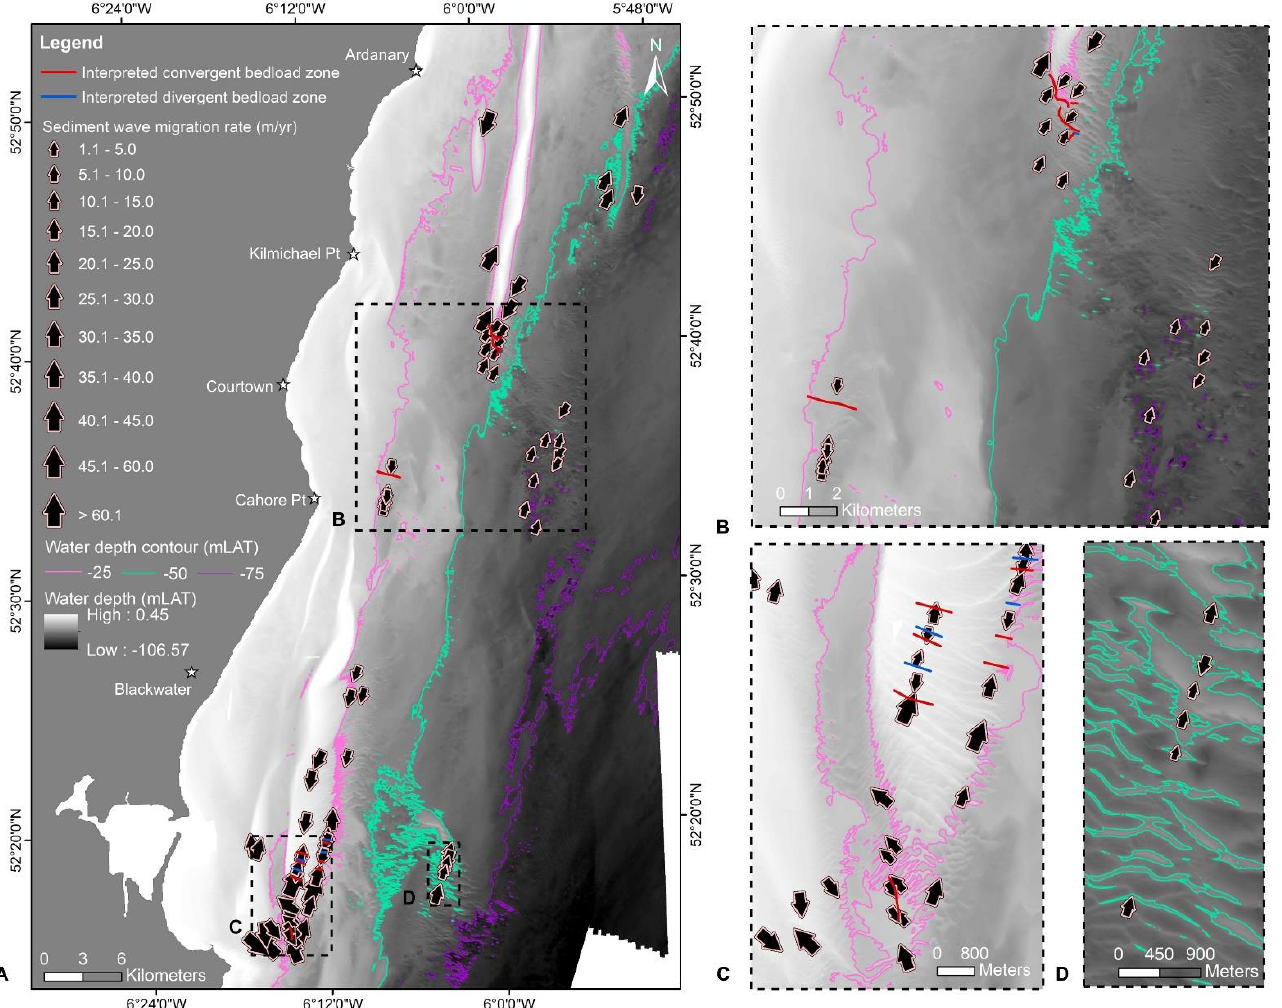
Figure 7. Average annual sediment wave migration rates updated with new time-lapse multi-beam echo sounder bathymetry datasets: ( A ) an overview of south-western Irish Sea, whereby the locations of ( B ) to ( D ) are indicated; ( B ) inset of study sites 1, 6 and 7; ( C ) inset of study sites 2 and 3; ( D ) inset of study site 5. See Figure 2 for study site boundaries. Figure bathymetry data source: composite map produced from INFOMAR datasets (referenced to Lowest Astronomical Tide (LAT)) (https://www.infomar.ie/data [Accessed: 10 June 2021]) (see Section 3.1).